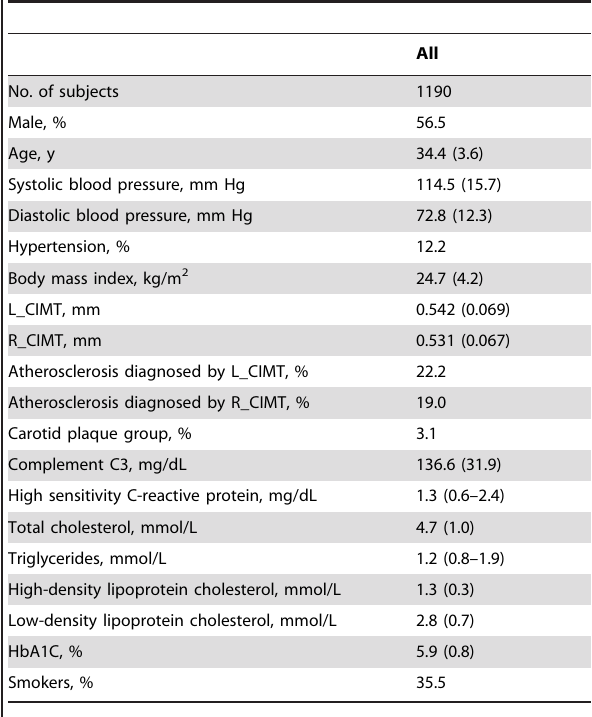
Table 1. Basic characteristics of participants in this study.